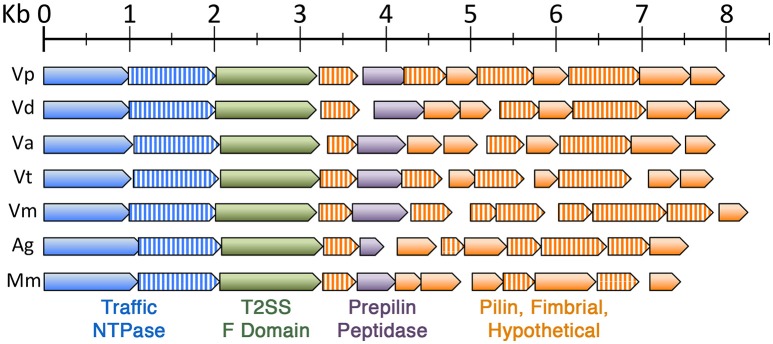
The V. parvula competence locus is highly conserved in the Veillonellaceae family. Chromosome maps of similar competence gene loci found among other members of the Veillonellaceae family. ORFs are all drawn to scale and are color coded as follows: blue (traffic NTPase), blue striped (PilT-type traffic NTPase), green (T2SS F domain protein), purple (prepilin peptidase), orange (pilin, fimbrial, or hypothetical), and orange striped (pilin, fimbrial, or hypothetical with a putative A24 prepilin peptidase cleavage/N-terminal methylation motif). The species and corresponding NCBI gene locus tags of putative competence gene loci are: Veillonella parvula (Vp, VPAR_RS05490—VPAR_RS05435), Veillonella dispar (Vd, VEIDISOL_RS04670—VEIDISOL_RS04725), Veillonella atypica (Va, HMPREF0870_00539—HMPREF0870_00528), Veillonella tobetsuensis (Vt, VEI_RS05560—VEI_RS05505), Veillonella montpellierensis (Vm, HMPREF0872_RS02280—HMPREF0872_RS02225), Anaeroglobus germinatus (Ag, HMPREF0080_RS06235—HMPREF0080_RS06175), and Megasphaera micronuciformis (Mm, HMPREF9429_RS07325—HMPREF9429_RS07270).